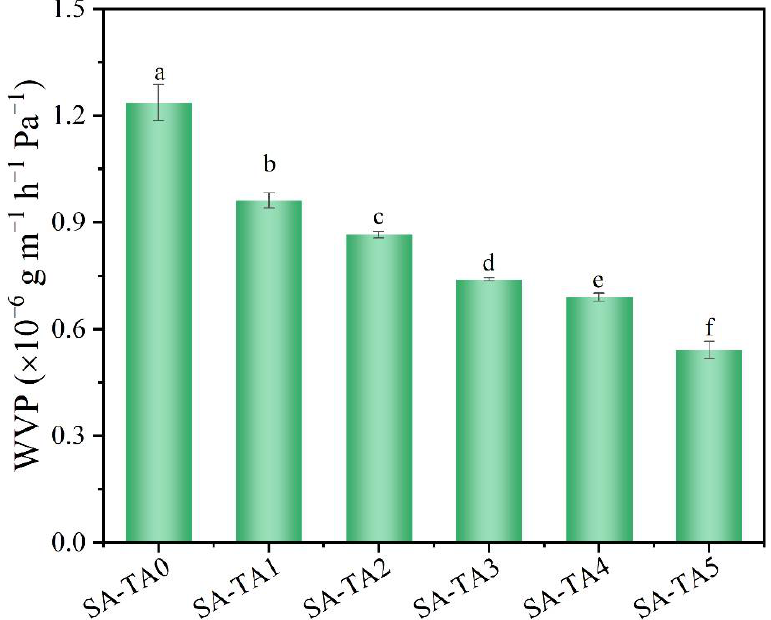
Figure 5. Water permeability of SA and SA-TA films. Different letters indicate significantly different groups ( p < 0.05) based on ANOVA followed by Tukey test.